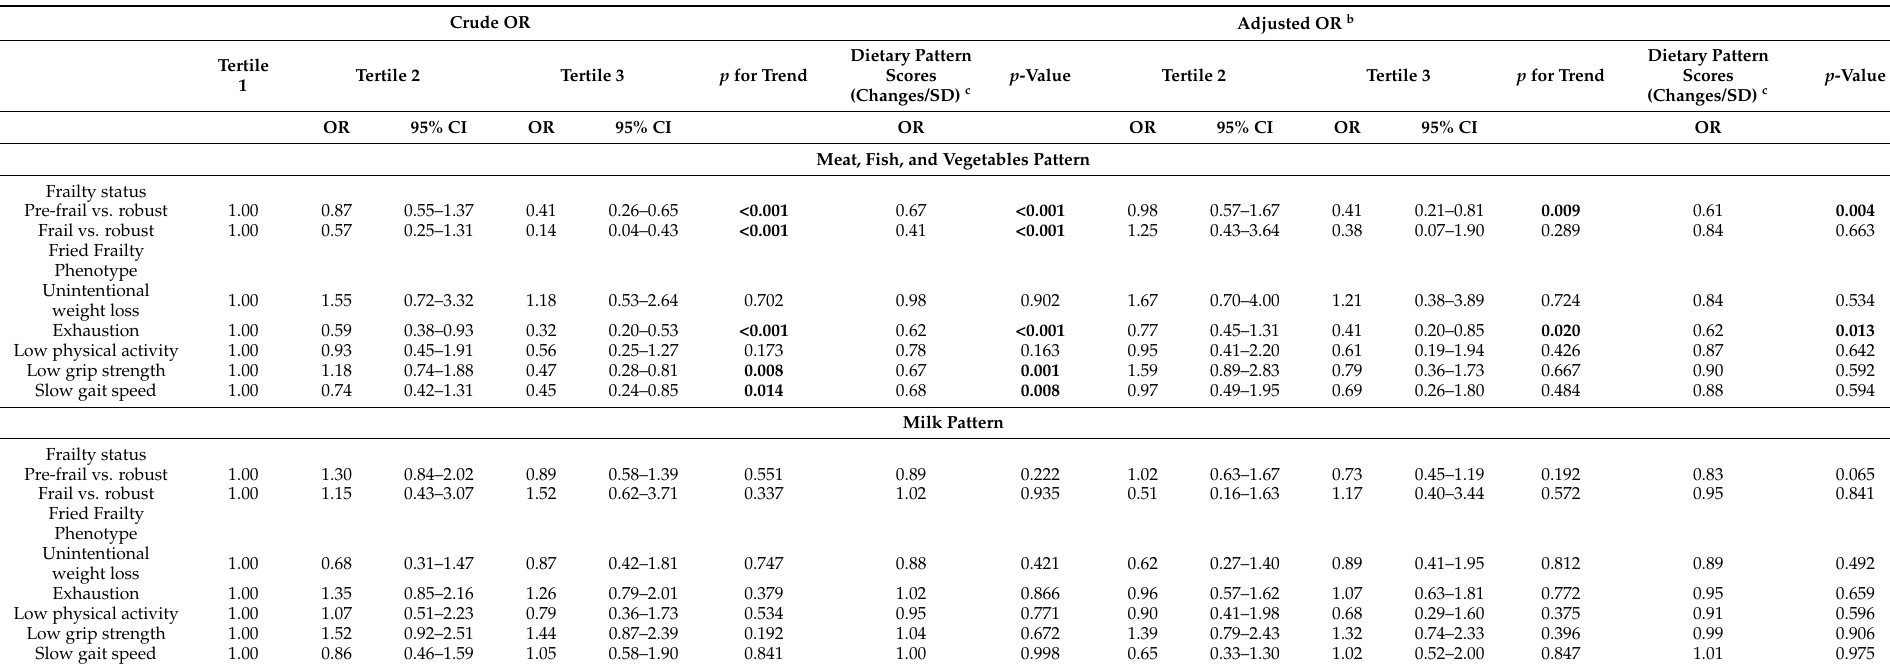
Table 4. Odds ratio (OR) and 95% confidence interval (CI) for frailty and the Fried Frailty Phenotype according to dietary pattern scores a ( n = 511). Crude OR Adjusted OR b Dietary Pattern Tertile p for Trend p -Value Tertile 2 Tertile 3 p for Trend Scores 1 Tertile 2 Tertile 3 (Changes/SD) c